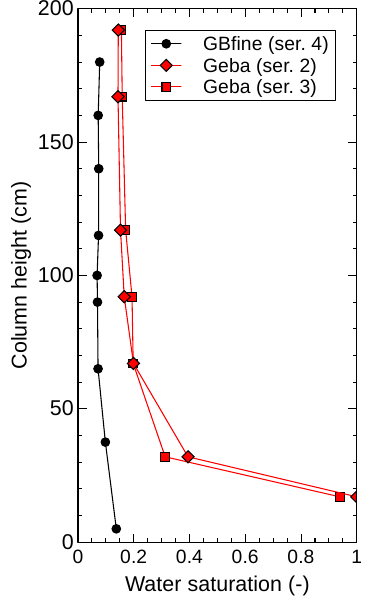
Figure 4. Initial water